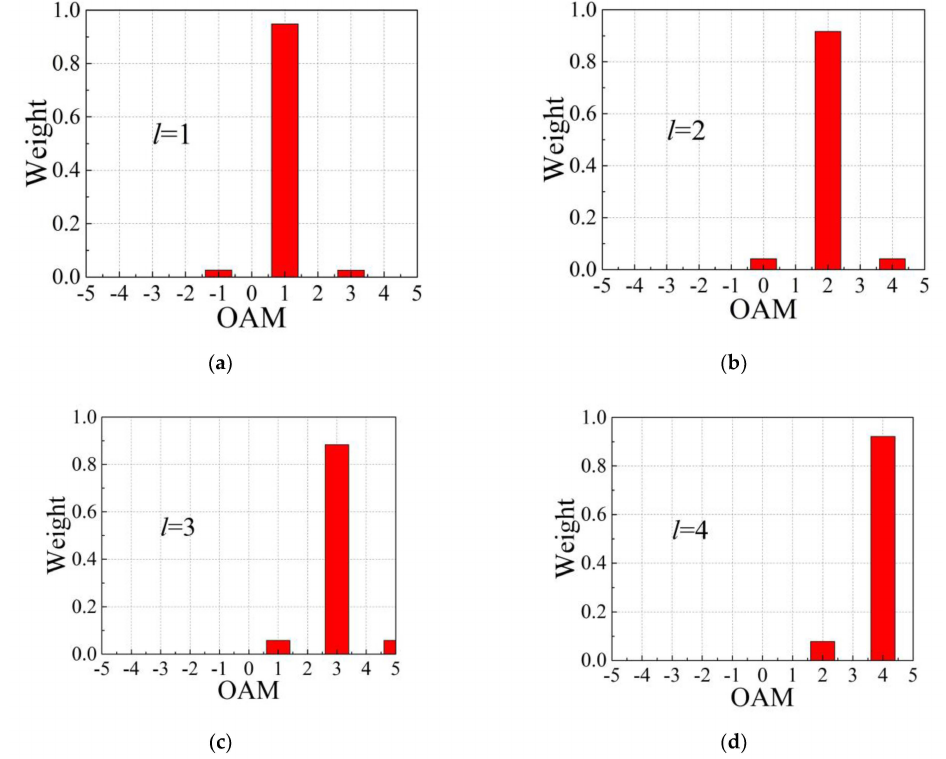
Figure 8. The same as in Figure 4, but the measurement plane is located at z = 50 µ